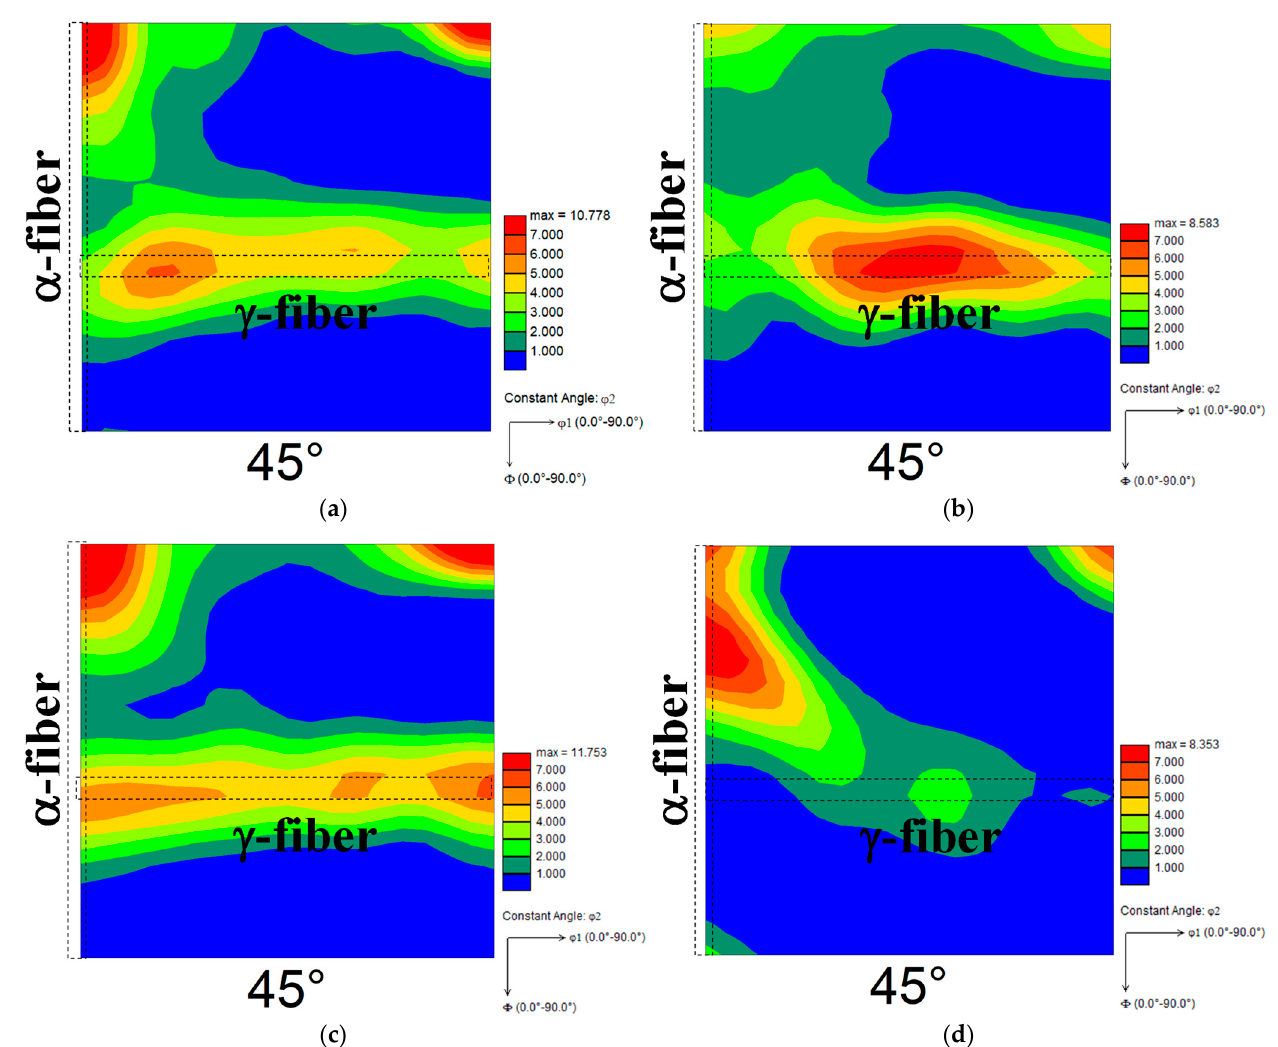
Figure 4. Two typical ODF maps of cold-rolled specimens ( a , b ) A and ( c , d ) B ( φ 2 = 45°